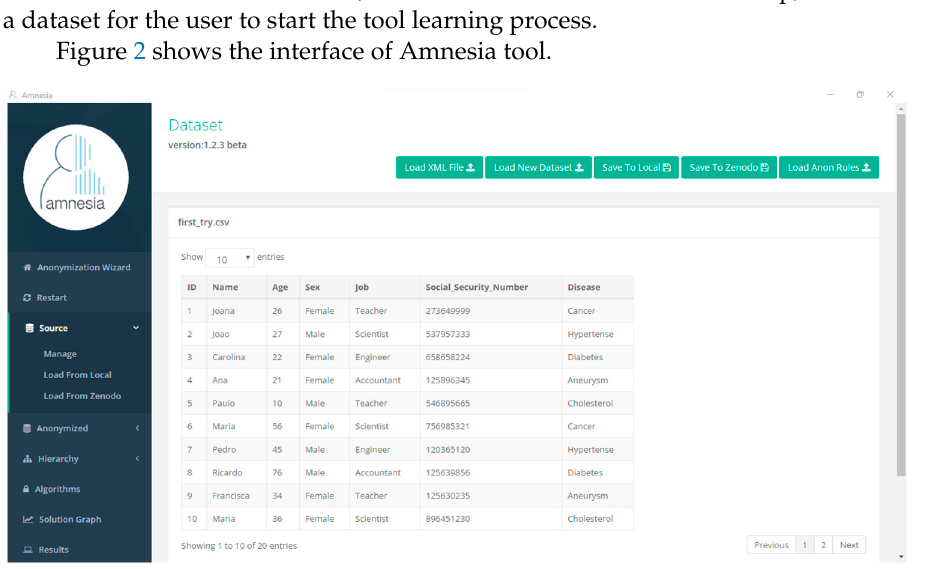
Figure 2. Amnesia interface.